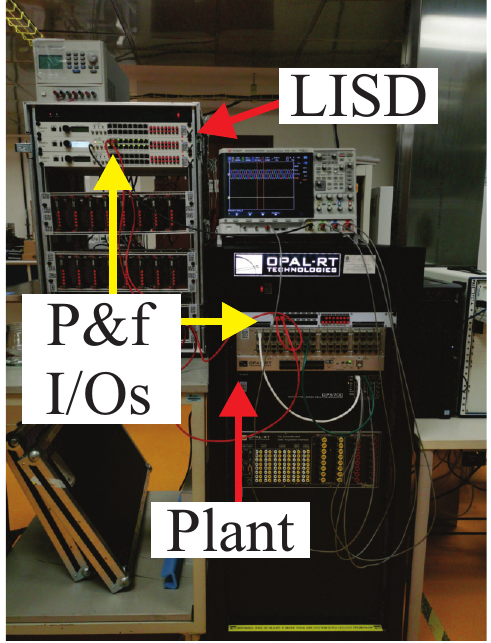
Figure 11. Real-Time Experimental